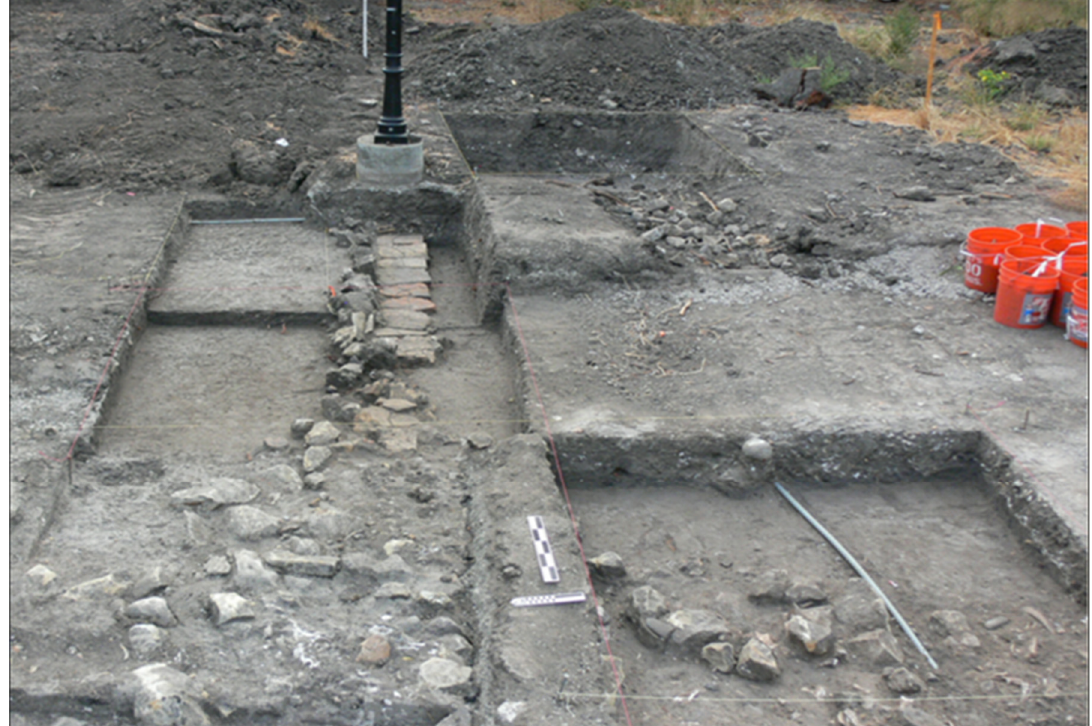
Figure 16. Overview of excavated cobble foundation alignment of adobe housing after GPR survey.